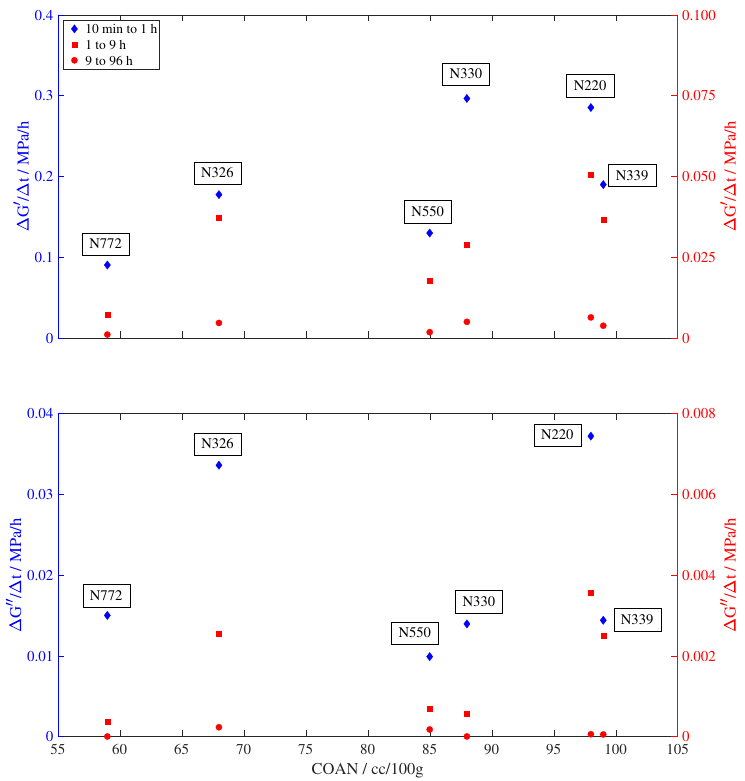
Figure 8. Dependency of the storage and loss modulus slope on the oil absorption number of the compressed sample (COAN). Slopes are calculated from 10 min to 1 h (blue diamond), 1 to 9 h (red square), and 9 to 96 h (red